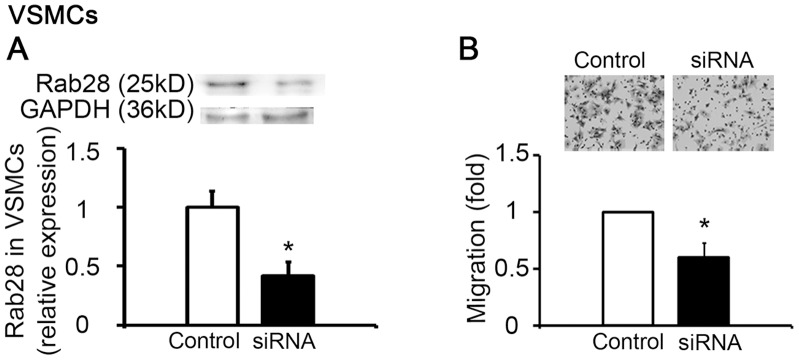
Rab28 knockdown changed cell migration in VSMCs.(A) Target siRNA transfection down-regulated the expression of Rab28. (B) The repressed expression of Rab28 decreased the migration of VSMCs. All results are given as mean ± s.d., *P<0.05, n = 7 each.